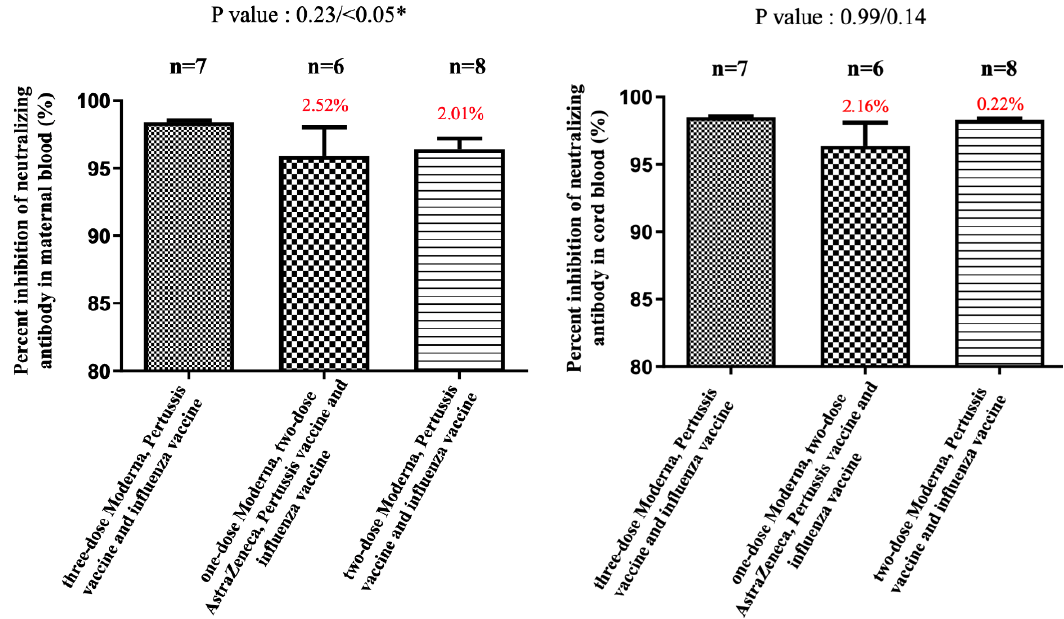
Figure 3. The percentage of inhibition of neutralizing antibody (%) against the wild type in maternal and cord blood. In the two AZ plus one Moderna group, there was a 2.52% reduction ( p = 0.23) in maternal blood and a 2.16% ( p = 0.99) reduction in cord blood compared with the three-dose Moderna. In the two-dose Moderna group, there was a 2.01% reduction ( p < 0.05) in maternal blood and a 0.22% ( p = 0.14) reduction in cord blood compared with the three-dose Moderna. *indicates statistically significant.